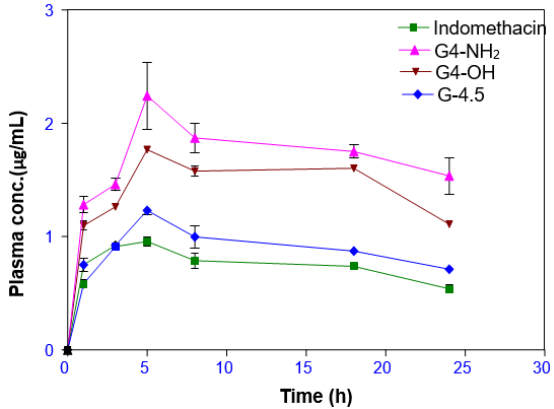
Figure 6. Transdermal delivery of dendrimer formulations (G4-NH2, G4-OH, G4.5-COOH dendrimers, indomethacin). Reproduced with permission [2].